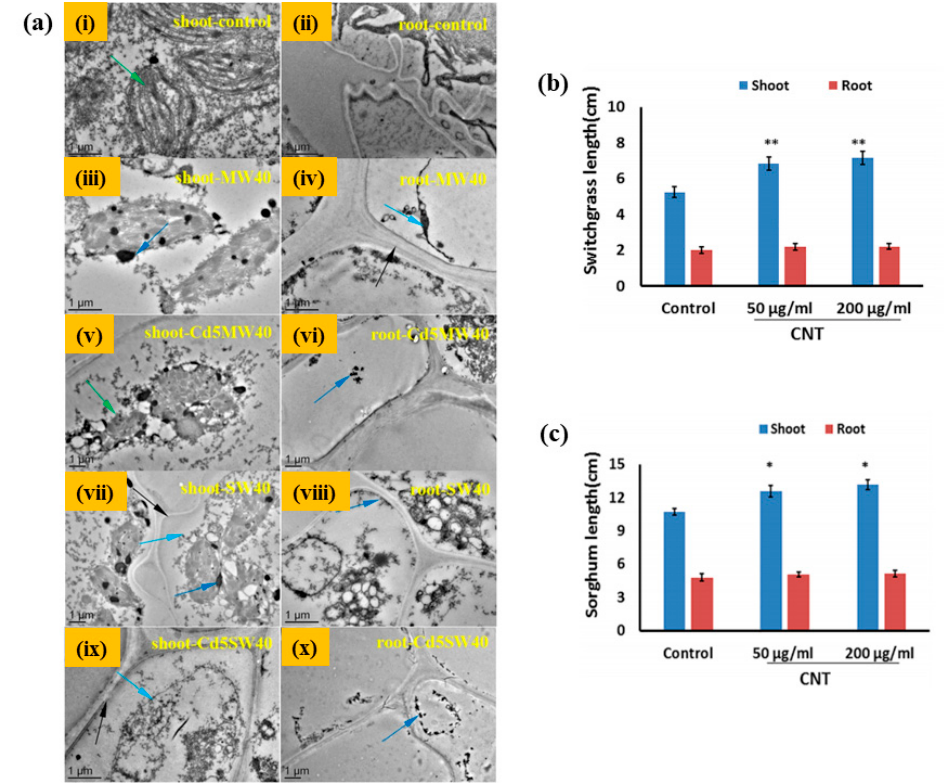
Figure 4. ( a ) Transmission electron microscopy images of plant cells. Green arrows indicate chloroplasts in ( i , v ); black arrows indicate the cell wall for ( iv , vii , ix ); navy blue arrows indicate CNTs deposition for ( iii , vi , vii , viii , x ); and light blue arrows indicate cell membrane in ( iv , vii , ix ) [73]. ( ii ) Growth enhancement on ( b ) switch grass and ( c ) sorghum seedlings by exposure to carbon-based nanomaterials. Effects on growth of bioenergy crops by CNTs added to growth medium. Measurements were performed on 10-day-old seedlings (n = 30 for both sorghum and switch grass). (* p < 0.05 and ** p < 0.01) [75]. Table 3. The effects of different carbon nanomaterials (CNMs) on plant and crop growth. Type of CNMs Effect Reference